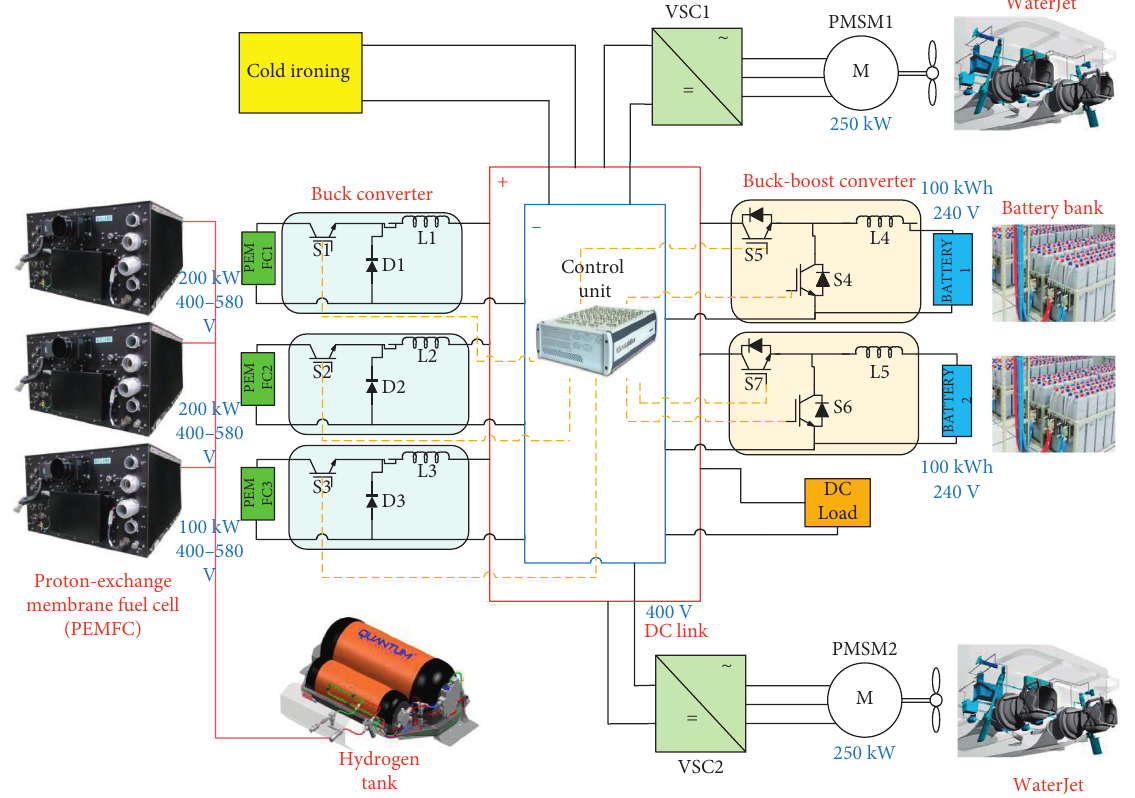
Figure 1: The proposed circuit of the hybrid energy system. Table 1: Technical characteristics of the PEM fuel cell-battery hybrid